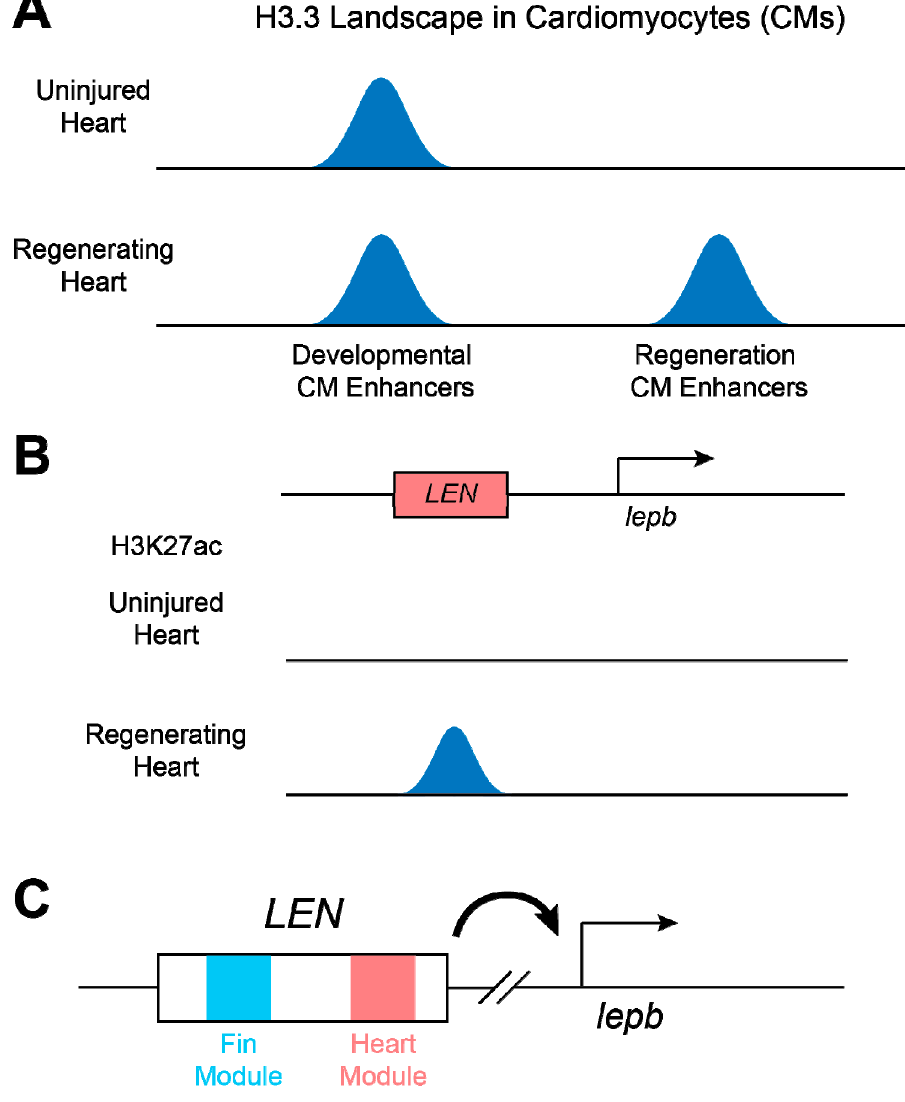
Figure 3. Cardiac regeneration enhancer elements. ( A ) Cardiomyocyte (CM)-specific enhancers in zebrafish. CM-specific histone H3.3 profiling of uninjured and regenerating zebrafish hearts captures regulatory elements preferential for heart development and regeneration. ( B ) ChIP-seq analysis with active enhancer markers, such as H3K27ac, identifies lepb -linked regeneration enhancer ( LEN ), which can direct regeneration-specific expression in hearts and fins of zebrafish. ( C ) LEN consists of tissue-specific regeneration modules, each of which mediates gene transcription in their target